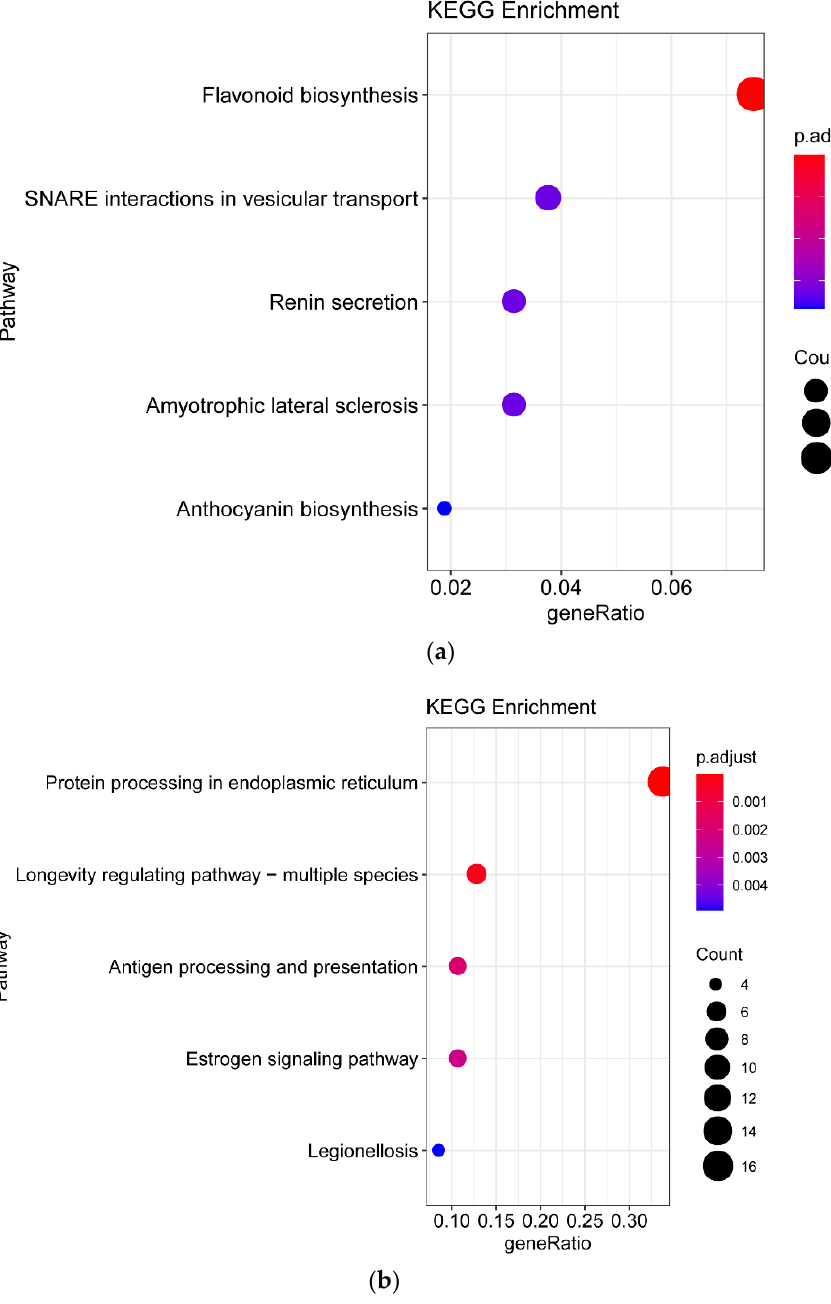
Figure 5. KEGG enrichment of DEGs in the root of Xiangshu99 vs. Zhezi No1. ( a ) upregulated genes; ( b ) downregulated genes.